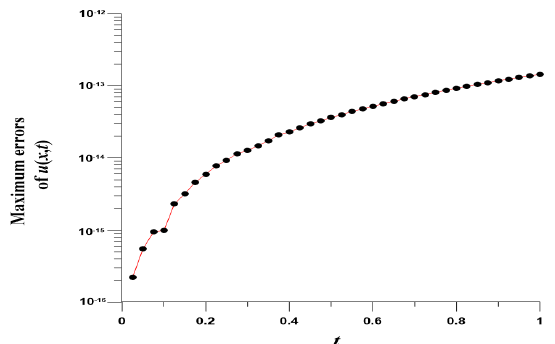
Figure 1. For Example 1: ME( u ) versus t .